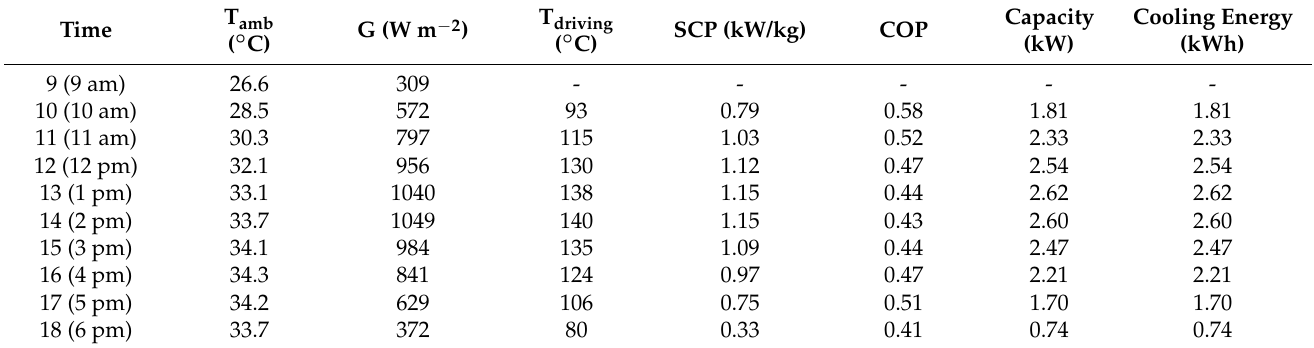
Table 5. Air conditioning performance with FPTSC (A col = 17.6 m 2 ) on the hottest day (5 April).